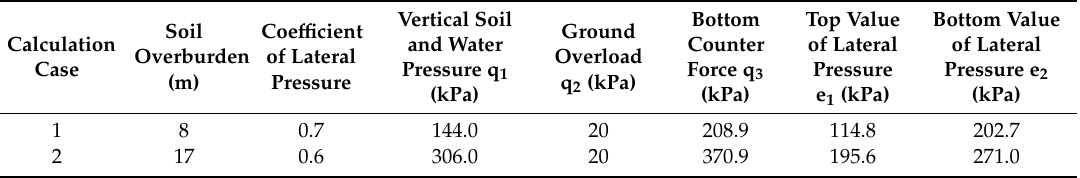
Table 5. Parameters for calculation